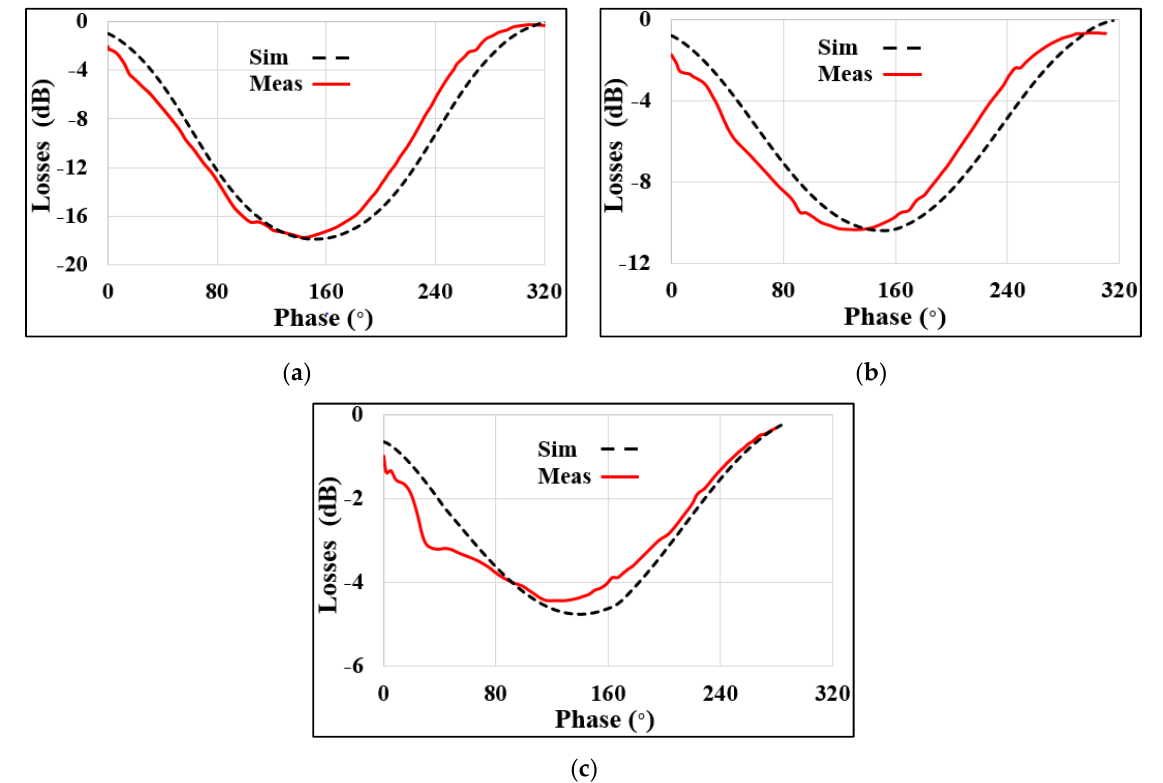
Figure 14. Reflection losses in the operating frequencies as a function of the reflection phase: ( a ) at 11 GHz, ( b ) at 12 GHz, and ( c ) at 13.5 GHz.